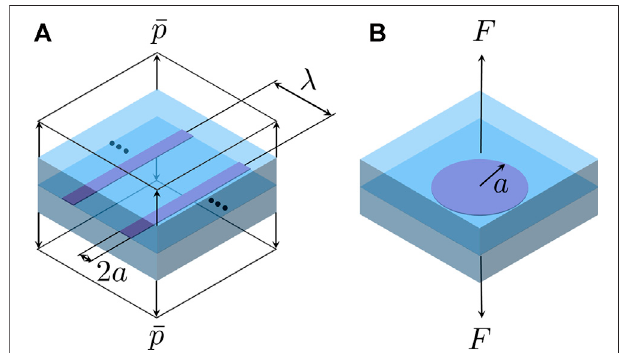
FIGURE 2 | Schematics of (A) periodic collinear cracks of period λ with semi-width a subjected to a uniform tensile normal traction (cid:1) p at far end, and (B) a penny-shaped external crack of radius a embedded in an in fi nite space subjected to a normal load F at far end. Only a fi nite portion of the in fi nite space is